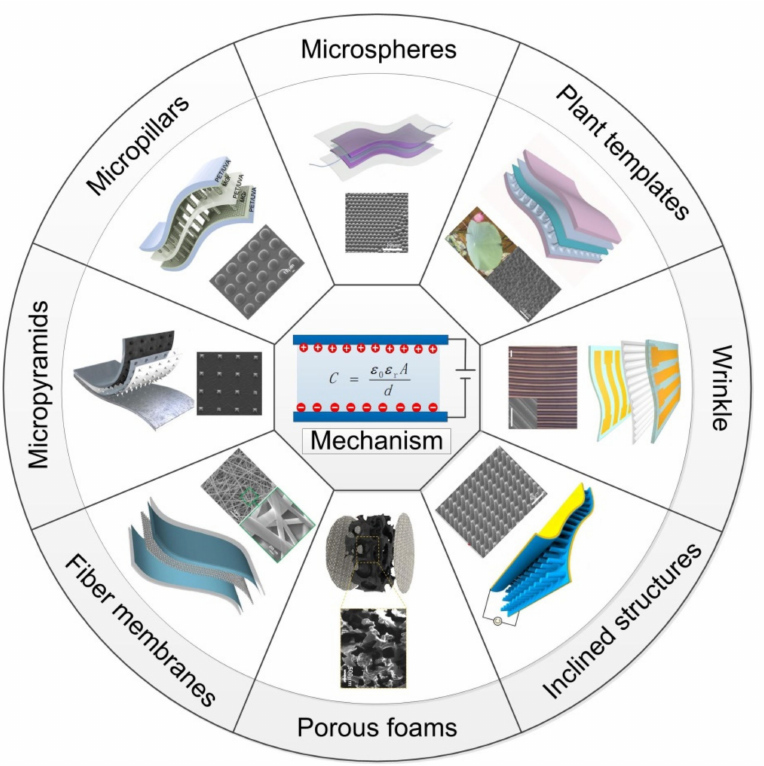
Figure 2. Capacitive pressure sensors based on different microstructures. (Micropyramids: